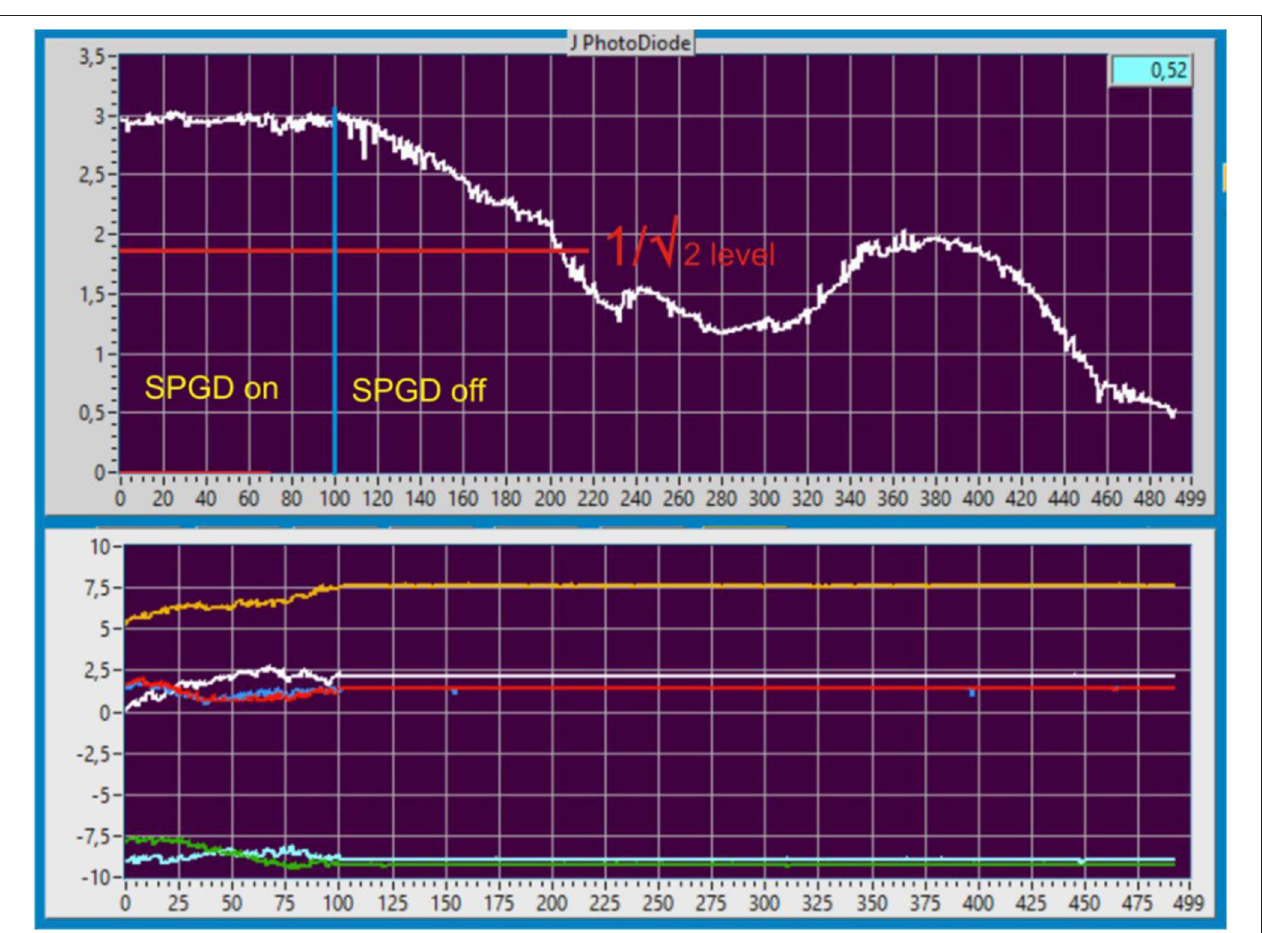
FIGURE 7 | Oscillogram of the signal at photodetector 13 with the SPGD controller turned off (top oscillogram). Dynamics of voltage at phase modulators (bottom oscillogram). Once SPGD is turned off, all voltages at the phase modulators are zero. The blue vertical line in the top oscillogram is for the time of SPGD turning off, the red horizontal line is for the signal decrease √ 2 times [ 20].